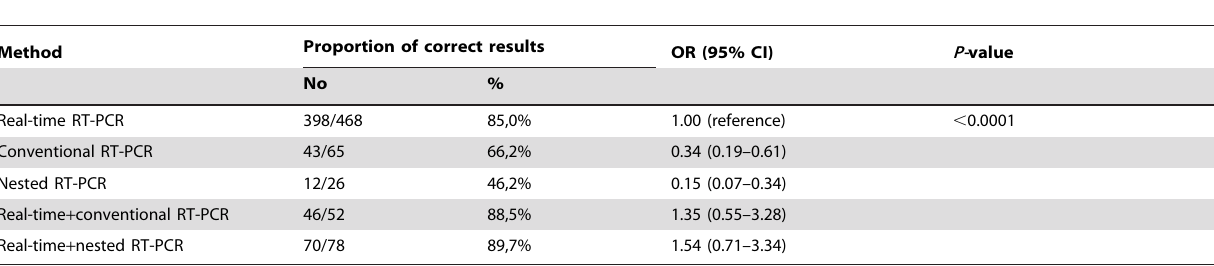
Table 3. Odd ratios obtained for each method by using real-time PCR as the reference.